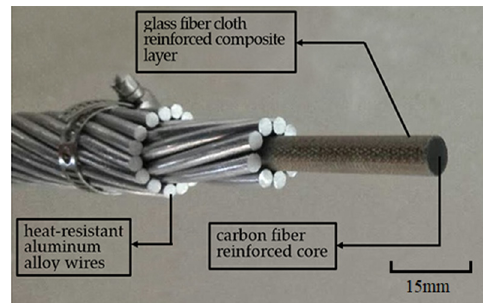
Figure 1. Conductor configuration of heat resistant aluminum alloy wire composite material core conductor (ACCC/HW).